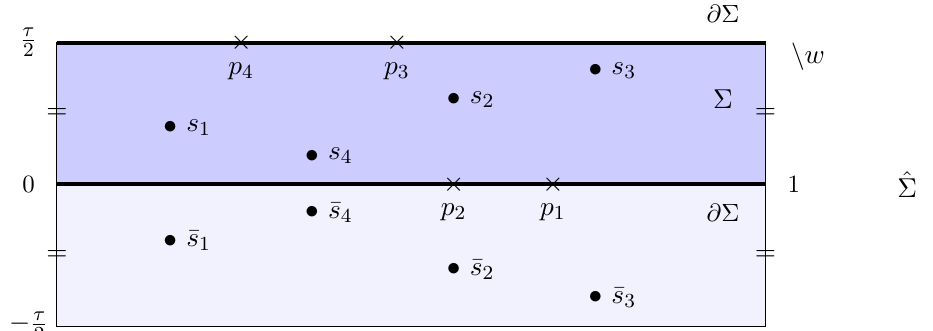
Figure 7 . The annulus (cid:6) is represented by the dark blue rectangle with periodic identi(cid:12)cation w (cid:17) w + 1; its boundary @ (cid:6) has two components denoted by thick black lines; the extension to the double surface ^(cid:6) is indicated by the light blue rectangle; four zeros s n of (cid:21) in the interior of (cid:6), and their complex conjugates (cid:22) s n , are indicated by black dots, while four poles p n distributed amongst the two boundary components are indicated by